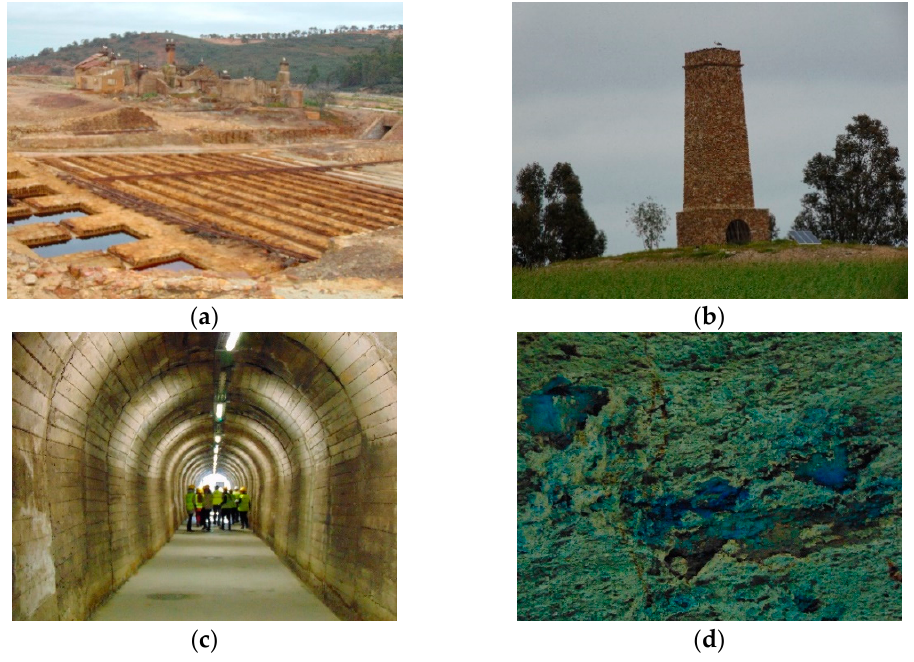
Figure 3. Valorization of the mining heritage during the remediation measures executed by EDM in the Aljustrel mine for the future Aljustrel Mining Park: ( a ) old cementation tanks; ( b ) the reconstructed Transtagana chimney; ( c ) the rehabilitation made in the Algares +30 level adit (gallery), allowing the observation of ( d ) the formation of secondary minerals through the oxidation of sulfides (Images courtesy of Cátia Micaelo, December 2016).